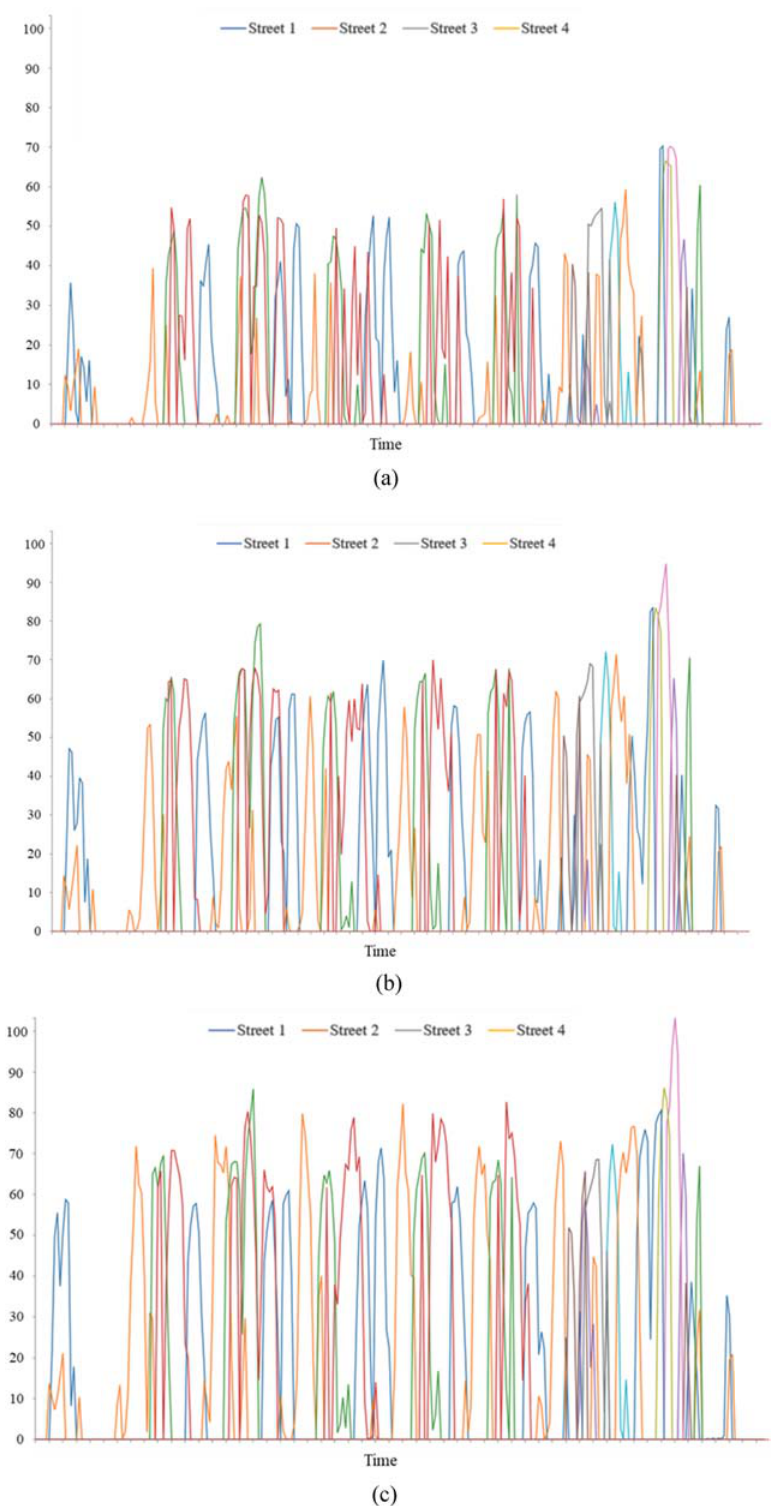
Figure 5: Speed coordinative calculation: ( a ) minimum speed calculation, ( b ) average speed calculation, and ( c ) maximum speed